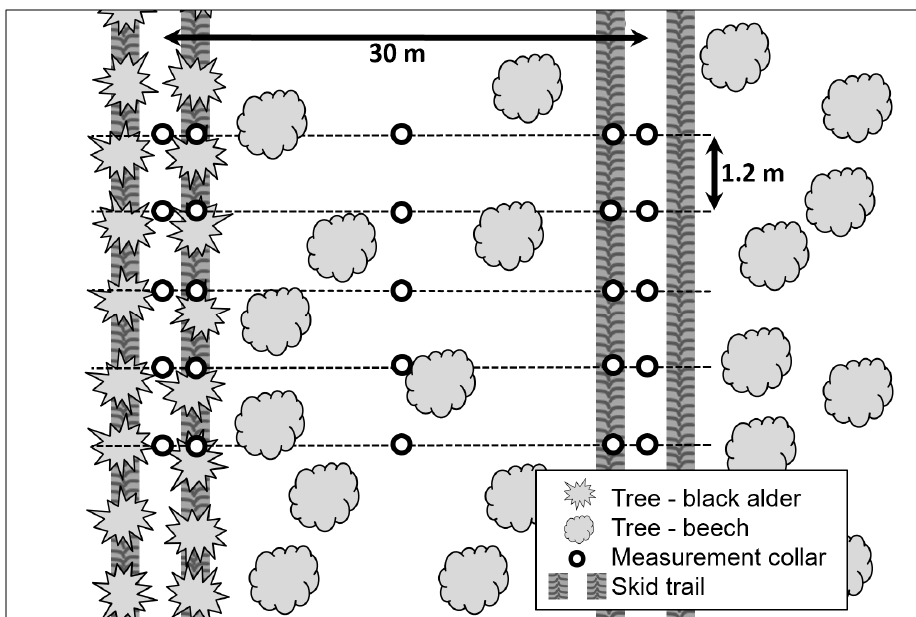
Figure 1. Sketch of the experimental design with the two investigated skid trails. Measurement collars were installed along five replicate transects in the wheel tracks of each skid trail, in the center bulges and in the undisturbed stand between the skid trails.